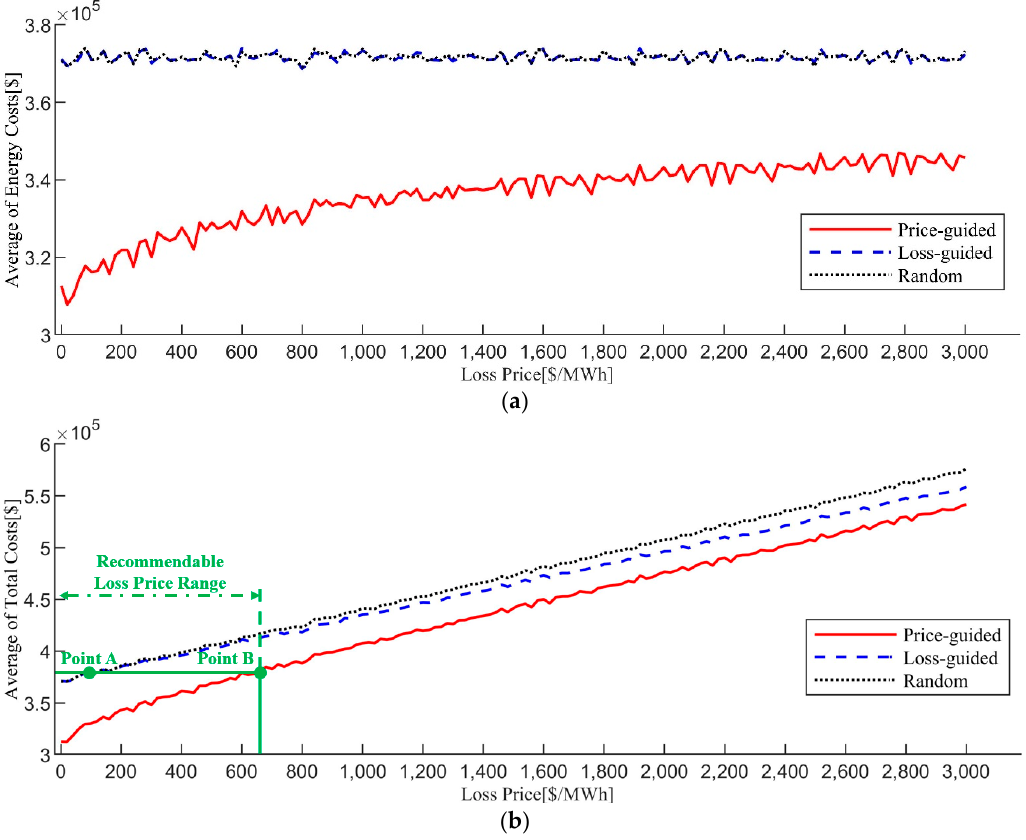
Figure 10. Average of ( a ) Energy Costs and ( b ) Total Costs with Increase in Loss Price.